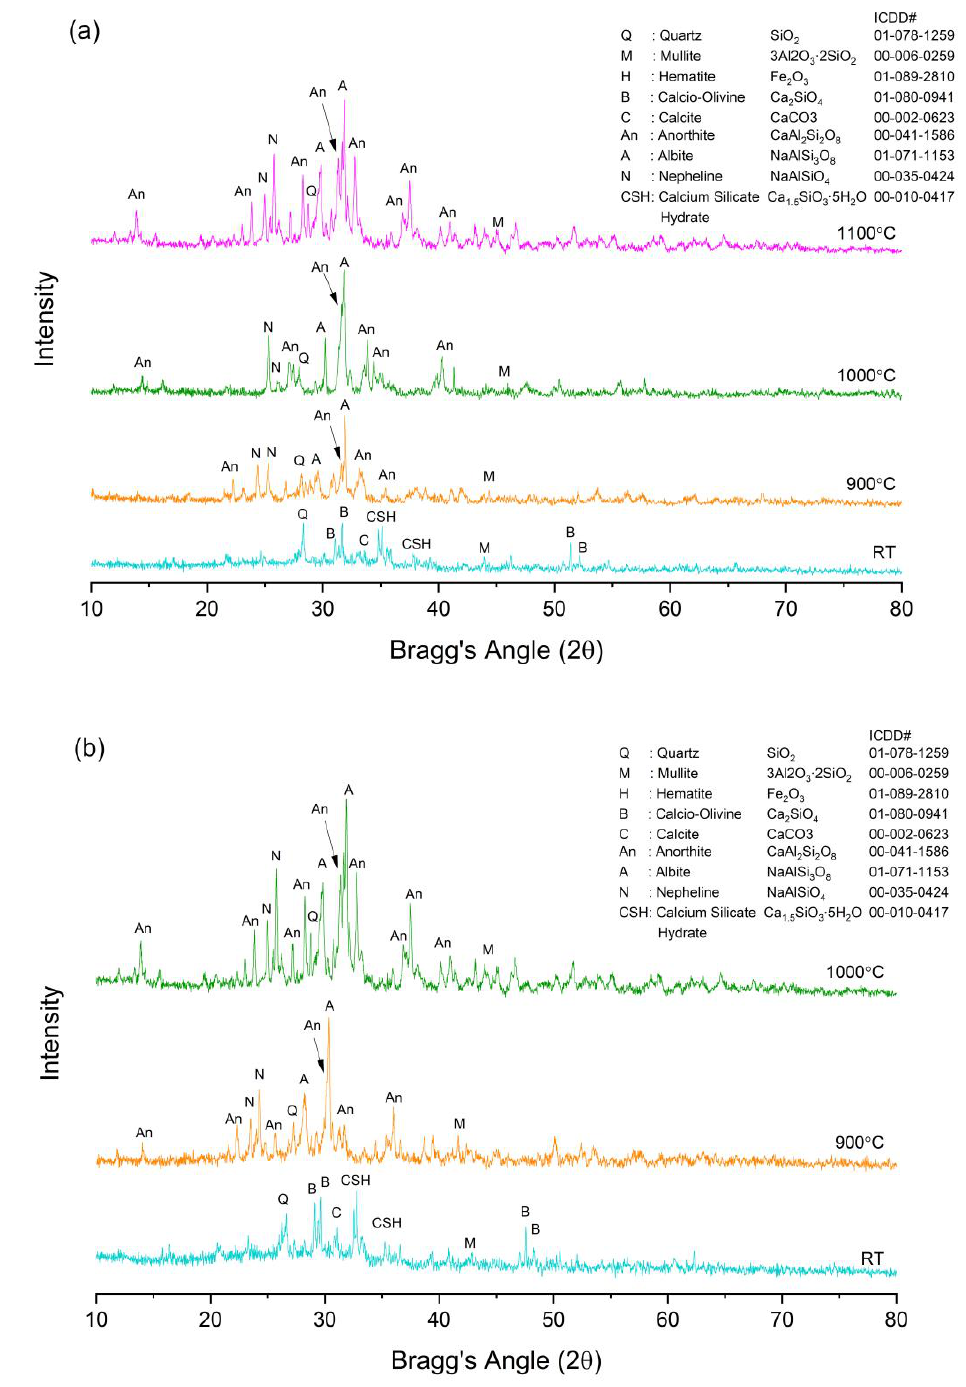
Figure 14. XRD diffractograms of unexposed and exposed ( a ) FAS and ( b ) FAB8 geopolymers.